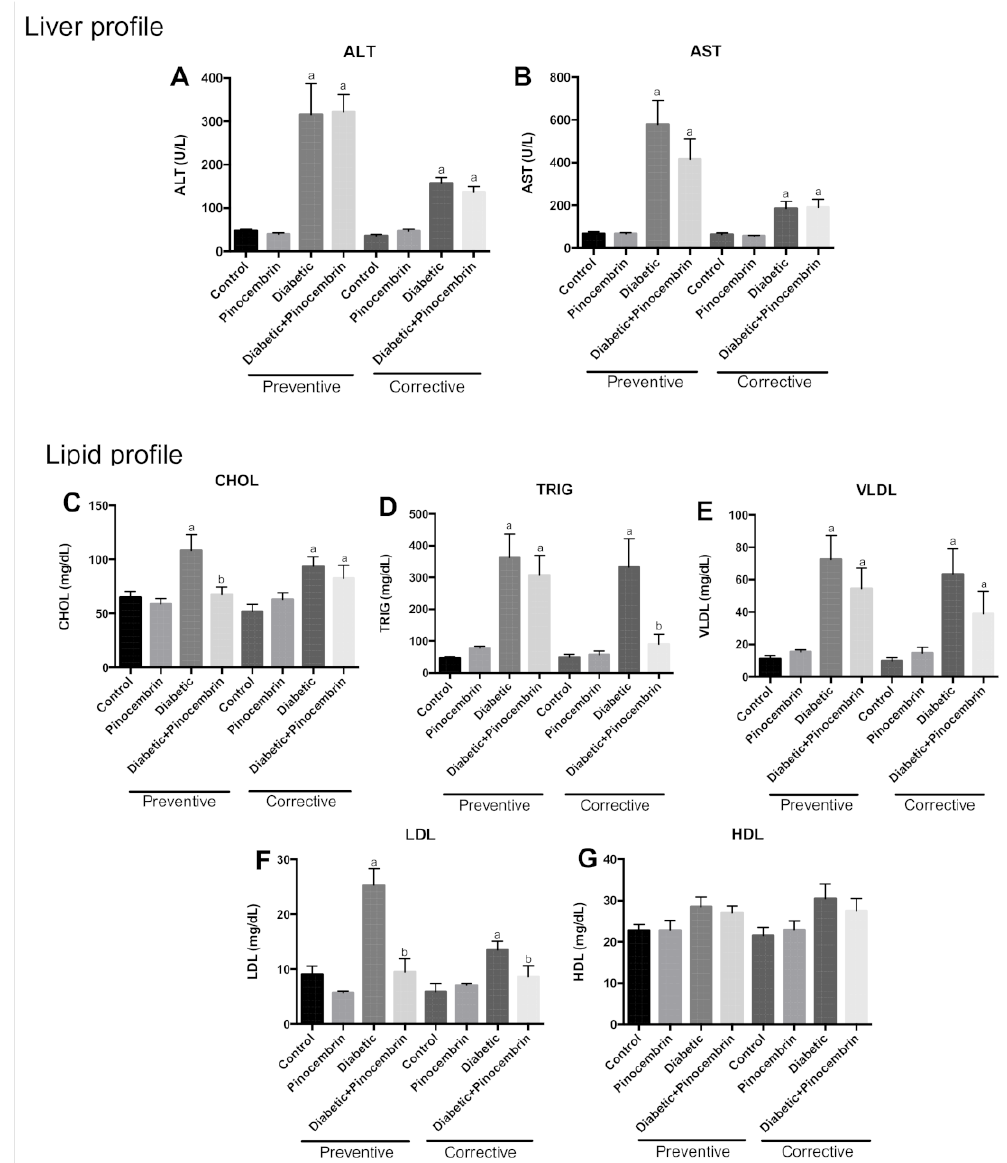
Figure 2. Hepatic profile in the schemes of treatment with pinocembrin, 40th day in the preventive scheme and 60th day in the corrective scheme. ( A ) Levels of ALT in preventive and corrective scheme ( B ) Levels of AST in preventive and corrective schemes. Lipid profile in the schemes of treatment with pinocembrin, 40th day in the preventive scheme and 60th day in the corrective scheme; ( C ) Cholesterol (CHOL) levels in preventive and corrective schemes; ( D ) Triglycerides (TRIG) levels in preventive and corrective schemes ( E ) Very Low Density Lipoprotein (VLDL) levels in preventive and corrective schemes ( F ) Low Density Lipoprotein (LDL) levels in preventive and corrective schemes ( G ) High Density Lipoprotein (HDL) levels in preventive and corrective schemes. a p < 0.02 vs. Control; b p <